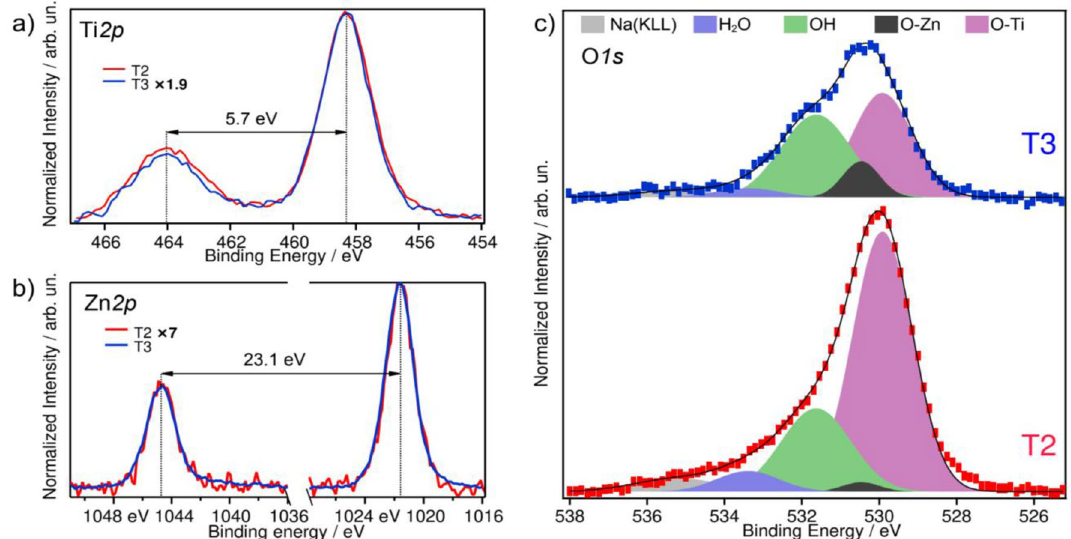
Figure 10. XPS spectra of the Ti2p ( a ) and O1s regions ( b ) for the samples T2 and